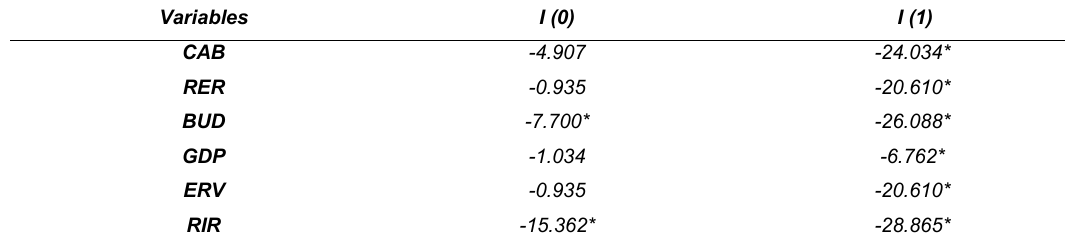
Table 3. Levin, Lin & Chu unit root